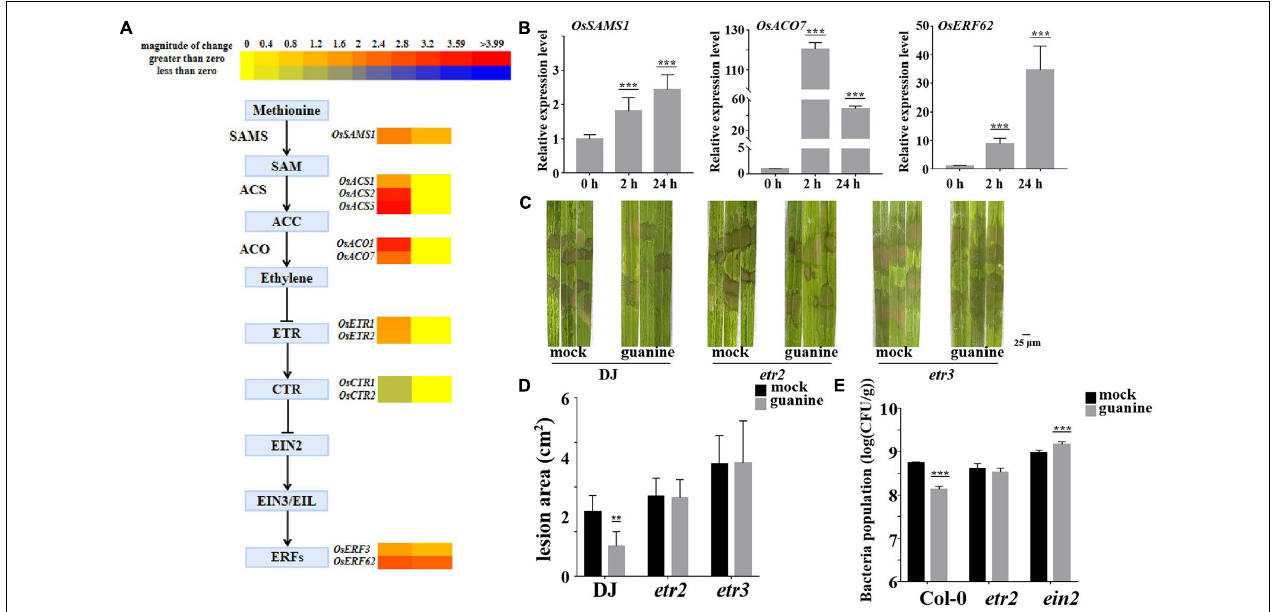
FIGURE 4 | Guanine activated ET signaling pathway gene expression and enhanced plant disease resistance dependent on ethylene receptors. (A) Heatmap analysis of ET biosynthesis and response gene expression after guanine treatment at 2 and 24 hpt. (B) qRT-PCR for the detection of ethylene pathway genes OsSAMS1 , OsACO7 , and OsERF62. The horizontal coordinates indicate the time of guanine- and mock-treated rice, and the vertical coordinates indicate the relative gene expression levels of guanine compared to the mock at the same time point. (C) Susceptible phenotype of the etr2 and etr3 mutant plants. Leaves of the rice plants treated with the mock and 100 ng/mL guanine prior to R. solani strain YWK196 inoculation. The disease symptoms were photographed at 3 dpi. (D) Measurement of the area of (C) by ImageJ. Asterisks indicate P < 0.01 (**) in Student’s t -test analysis. (E) Bacterial population in Col-0, etr1 and ein2 plant leaves. Arabidopsis leaves treated with the mock and 100 ng/mL guanine prior to Pst DC3000 inoculation. The bacterial population was calculated at 3 dpi. Asterisks indicate P < 0.001 (***) in Student’s t -test analysis.